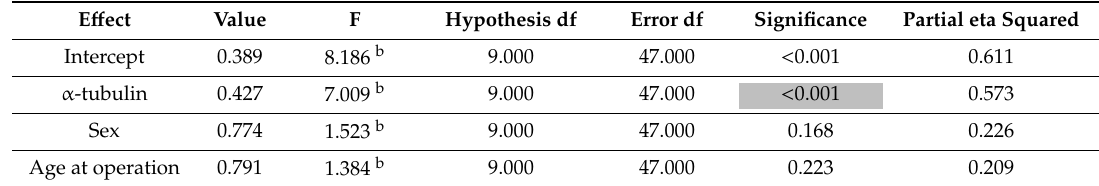
Table 7. Multivariate Tests a : α -tubulin (all samples), sex, and age at operation.